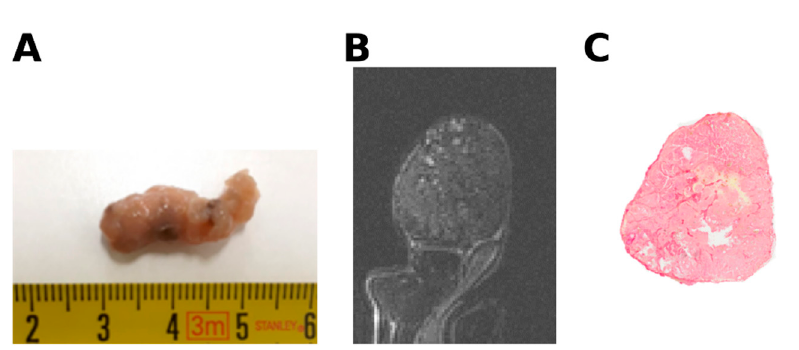
Figure 5. ( A ) Macroscopic view of excised tumor ( B ); tumor T2-weighted image. ( C ); correspond- ing picrosirius red stained section.